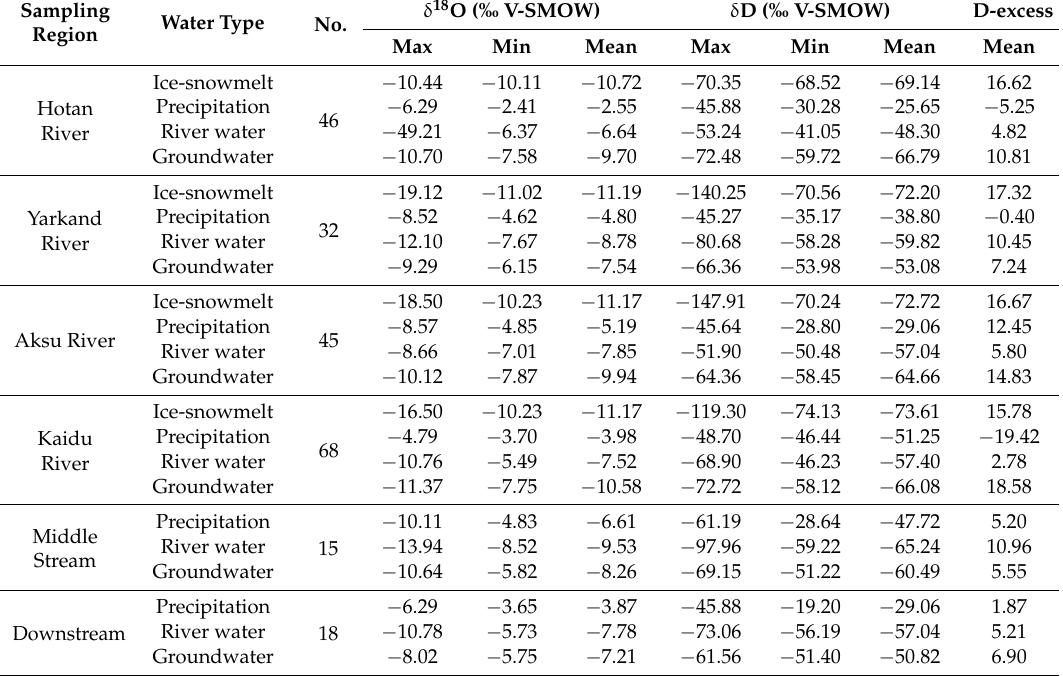
Table 1. Isotopic data from water samples collected in the four headstreams, the middle stream and downstream from 2012 to 2014, analyzed at the State Key Laboratory of Desert and Oasis Ecology, Xinjiang Institute of Ecology and Geography, Chinese Academy of